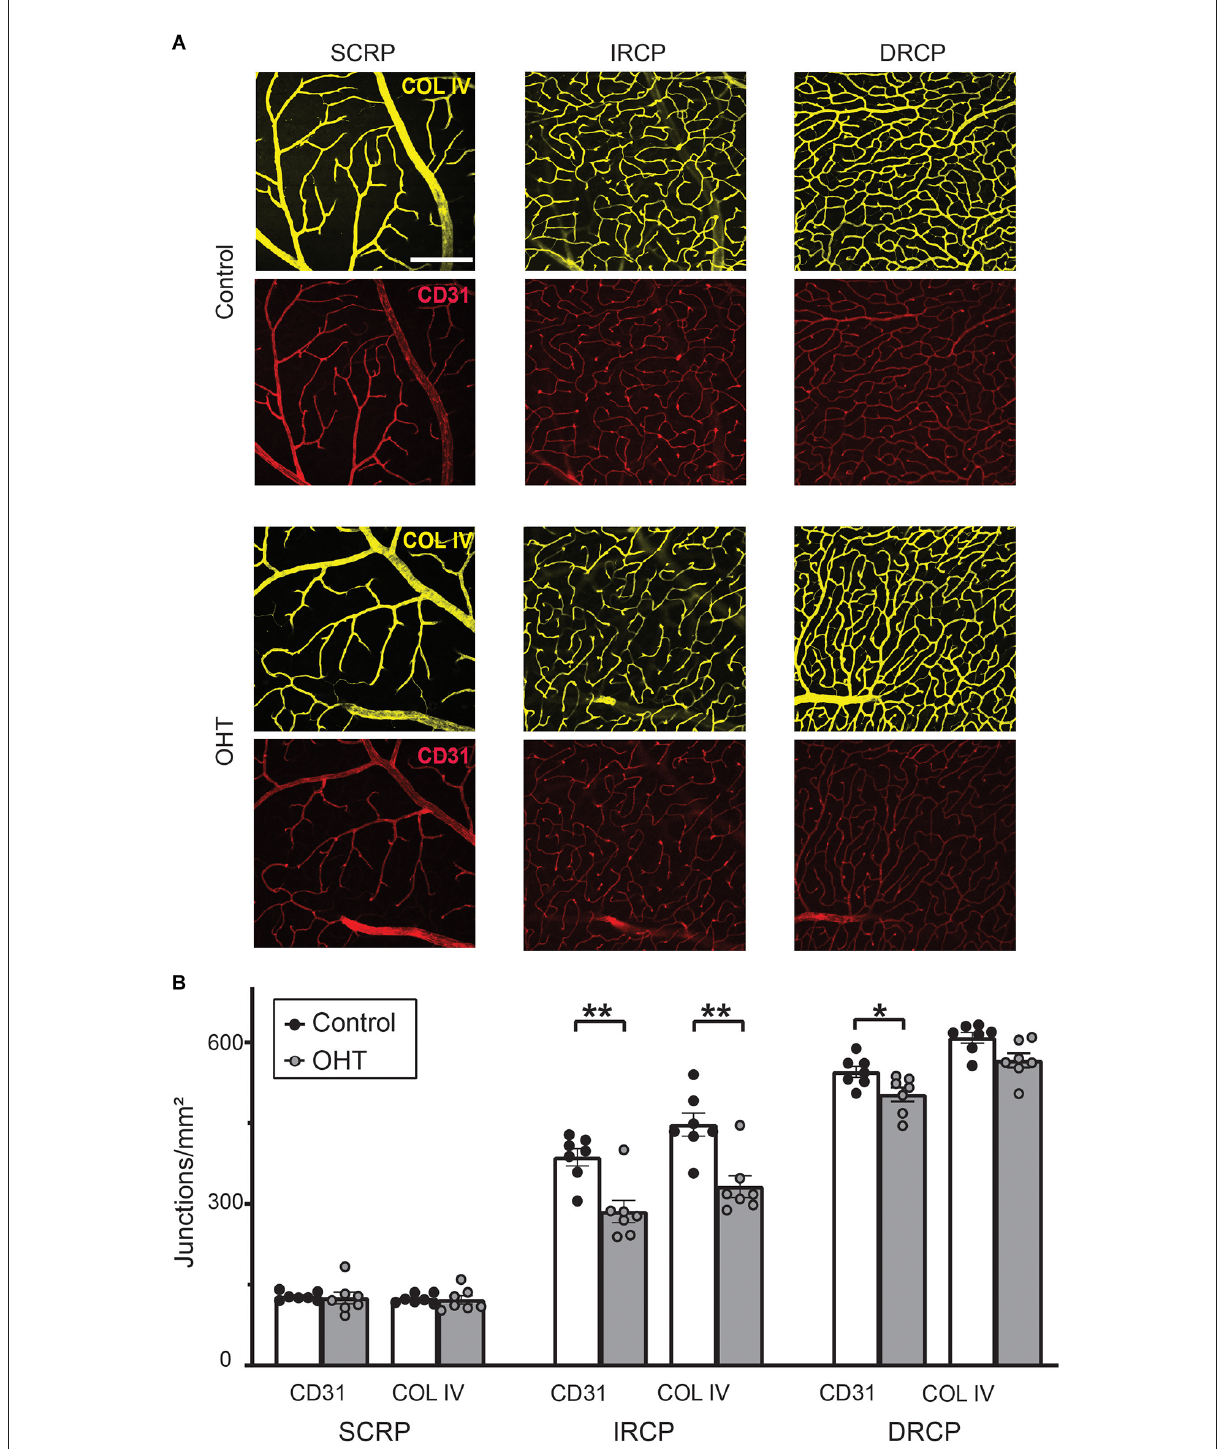
FIGURE3 (A) Representative images for Collagen IV and CD31 immunostained retinas for superficial retinal capillary plexus (SRCP), intermediate retinal capillary plexus (IRCP), and deep retinal capillary plexus (DRCP; scale bar = 200 µ m). (B) Junction density (number of junctions/mm 2 ) for CD31 and Collagen IV immunostained retinas. No significant changes were observed for the SRCP. There was a significant reduction in junction density for both CD31 and Collagen IV in the IRCP for OHT retinas (paired t -test; ** p < 0.01). Junction density was reduced for CD31 but not Collagen IV for OHT retinas in the DRCP (paired t -test; * p <